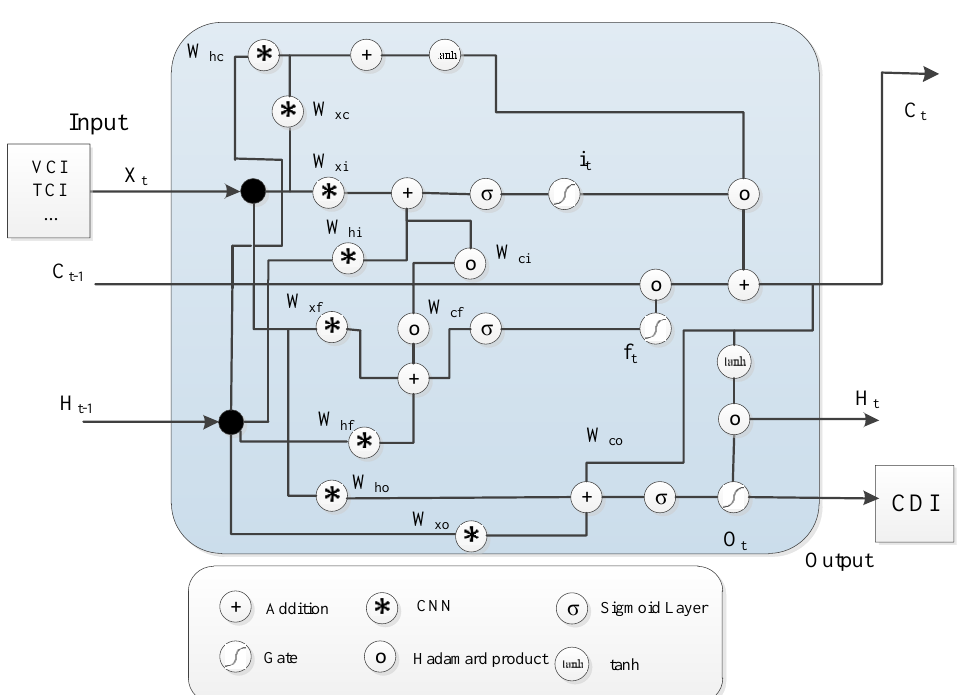
Figure 2. ConvLSTM internal network architecture. X, H, C, i, f, and o are the input sequence, hidden state, memory cell, input gate, forget gate, and output gate, respectively.